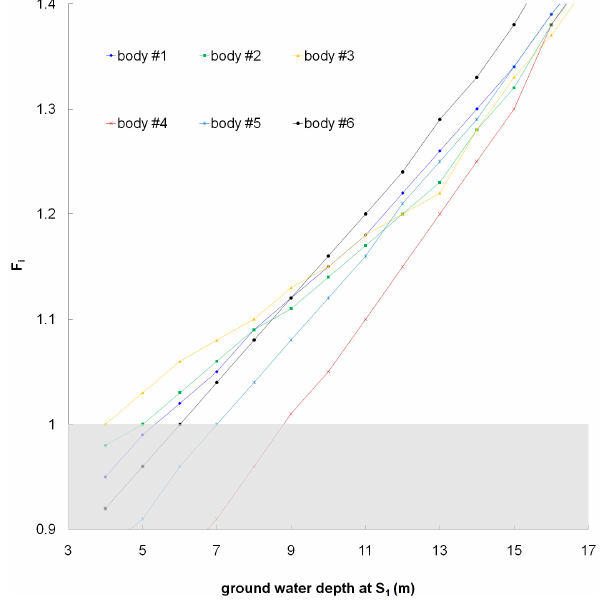
Fig. 11. San Rocco landslide: results of the LEM parametric anal- ysis. Values of F i computed for the six considered landslide bodies in relation to ground water levels at S 1 (cf. Table